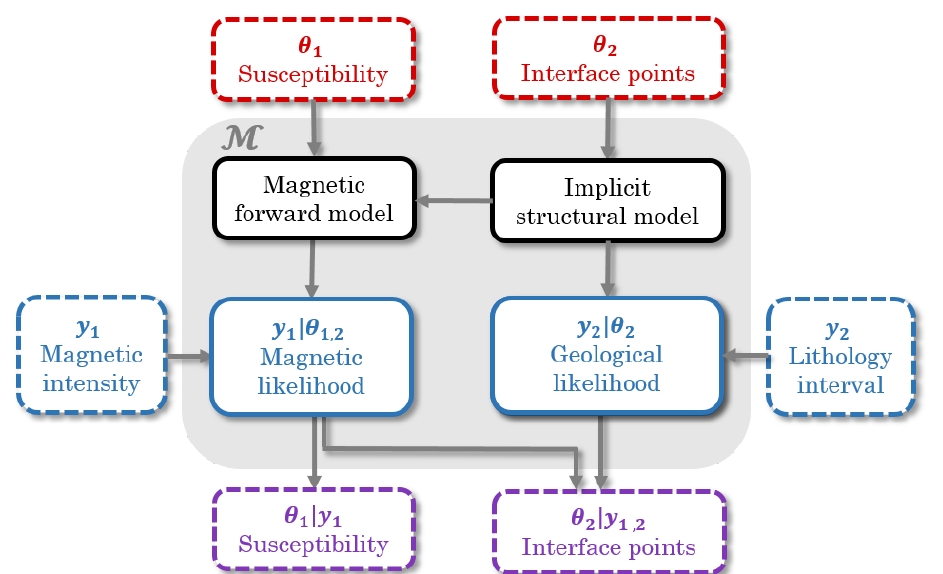
Figure 1. The Bayesian system for our probabilistic model with prior model parameters (red); governing equations (black) that relate model parameters and observations; likelihood functions (blue); observations (blue), with y 1 being observations from magnetic measurements and y 2 from core logs; and the posterior model parameters (purple). The governing equations and the likelihood functions together form the mathematical model M (grey area). Parameters are stochastic (dashed) or deterministic (solid). The arrows indicate parent-child like